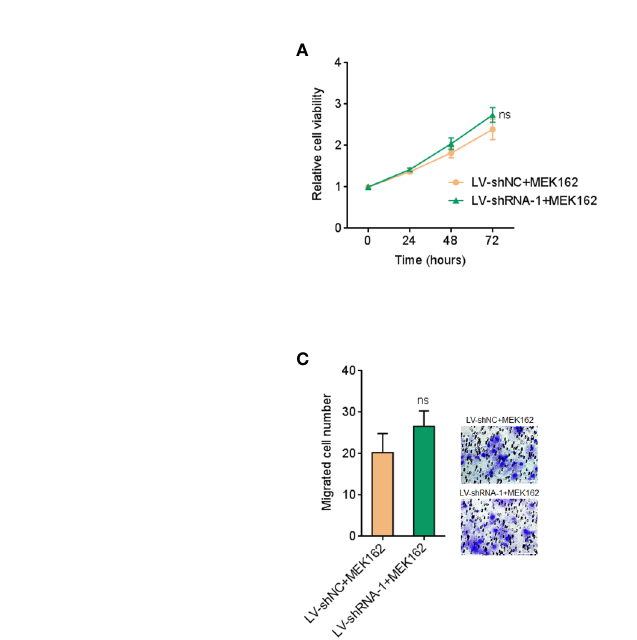
FIGURE 8 | MEK1/2 inhibitor MEK162 abolished the oncogenic roles of FUT8-AS1 silencing in melanoma. (A) CHL-1 cells silencing FUT8-AS1 or control were treated with 1 µM MEK162. Then, cell viabilities of treated cells were determined by the Glo cell viability assay. (B) CHL-1 cells silencing FUT8-AS1 or control were treated with 1 µM MEK162. Then, cell proliferation of treated cells was determined by the EdU incorporation assay. The red color indicates EdU-positive nuclei. Scale bars, 200 µm. (C) CHL-1 cells silencing FUT8-AS1 or control were treated with 1 µM MEK162. Then, cell migration of treated cells was determined by the transwell migration assay. Scale bars, 100 µm. (D) CHL-1 cells silencing FUT8-AS1 or control were treated with 1 µM MEK162. Then, cell invasion of treated cells was determined by the transwell invasion assay. Scale bars, 100 µm. Data are presented as mean ± SD. ns, not signi fi cant, by two-tailed unpaired t